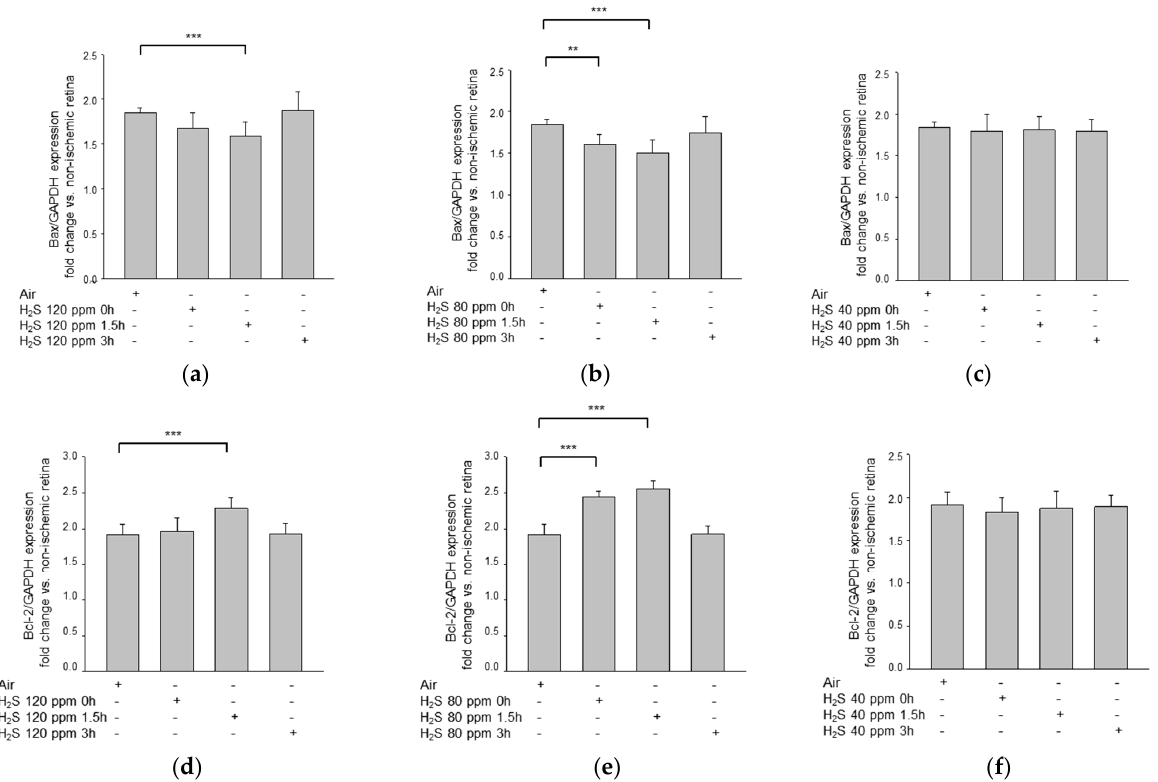
Figure 3. Effect of H 2 S inhalation on retinal expression of Bax and Bcl-2 mRNA. ( a – c ) Fold induction of Bax mRNA expression in ischemic retinal tissue compared to GAPDH in relation to the corresponding non-ischemic retinae analyzed by RT-PCR after ( a ) 120 ppm H 2 S inhalation (data are mean ± SD, n = 8; ** = p < 0.01, IRI vs. 120 ppm H 2 S at 1.5 h), ( b ) 80 ppm H 2 S inhalation (data are mean ± SD, n = 8; *** = p < 0.001, IRI vs. IRI + 80 ppm H 2 S at 1.5 h; ** = p < 0.01, IRI vs. IRI + 80 ppm H 2 S at 0 h), and ( c ) 40 ppm H 2 S inhalation. ( d – f ) Fold induction of Bcl-2 mRNA expression in ischemic retinal tissue compared to GAPDH in relation to the corresponding non-ischemic retinae analyzed by RT-PCR after ( d ) 120 ppm H 2 S inhalation (data are mean ± SD, n = 8; *** = p < 0.001, IRI vs. 120 ppm H 2 S at 1.5 h), ( e ) 80 ppm H 2 S inhalation (data are mean ± SD, n = 8; *** = p < 0.001, IRI vs. IRI + 80 ppm H 2 S at 1.5 h; *** = p < 0.001, IRI vs. IRI + 80 ppm H 2 S at 0 h) and ( f ) 40 ppm H 2 S inhalation.